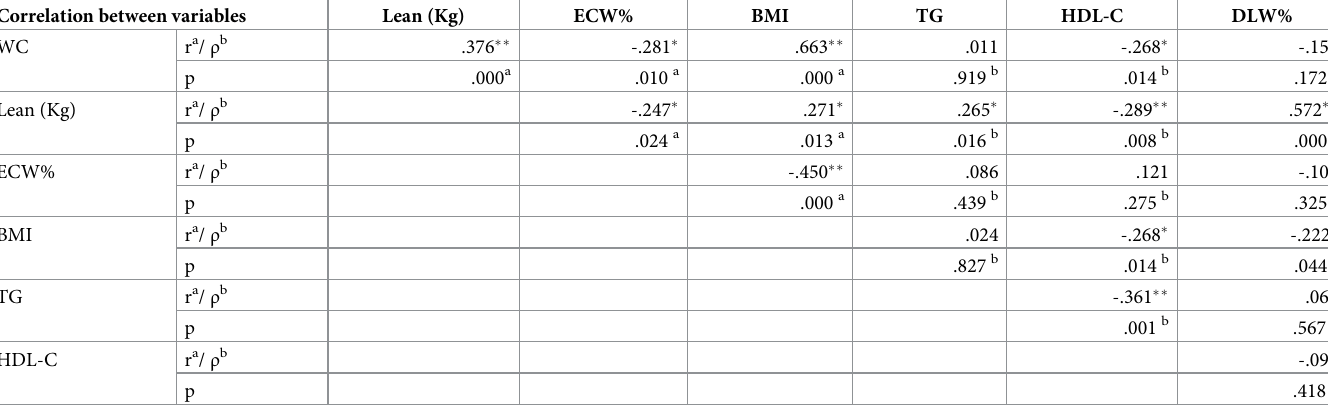
Table 2. Correlation between anthropometric measurements, body composition parameters and lipid profile in PD group (n = 83). Correlation between variables